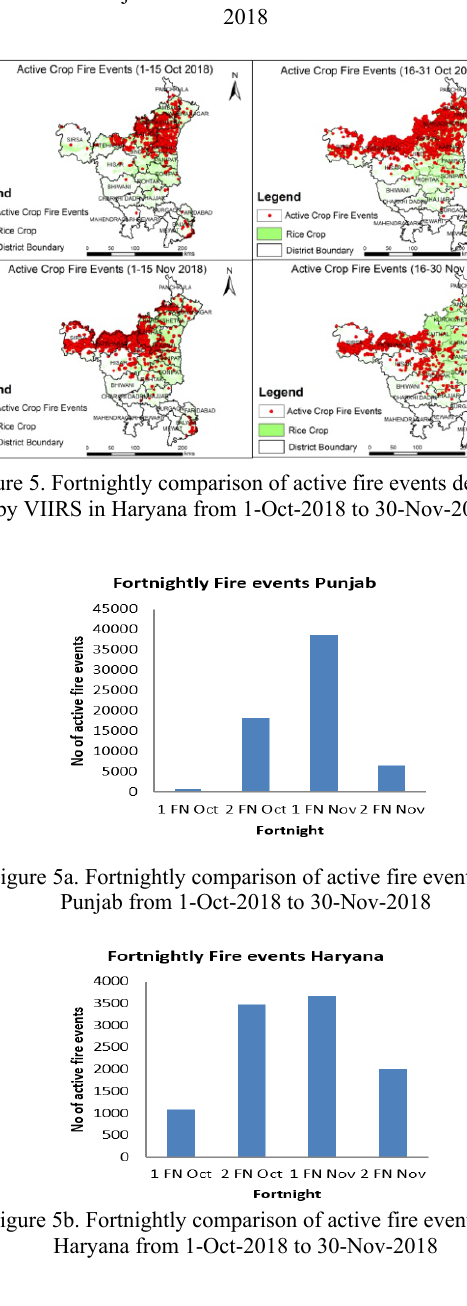
Figure 2. Rice growth pattern for estimation of harvesting pattern (from NDVI data) of Mansa district of Punjab, 2018 vis- à-vis average of 2015 to 2017 Figure 4. Fortnightly comparison of active fire events detected